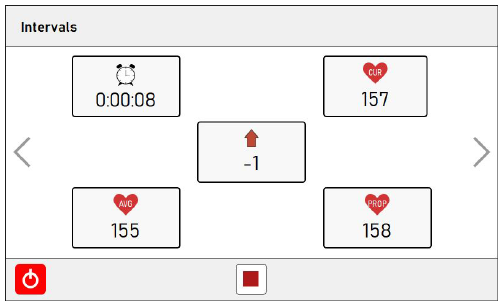
Figure 3. Implementation of the interval training session with the depiction of the digital twin prediction on a Raspberry Pi